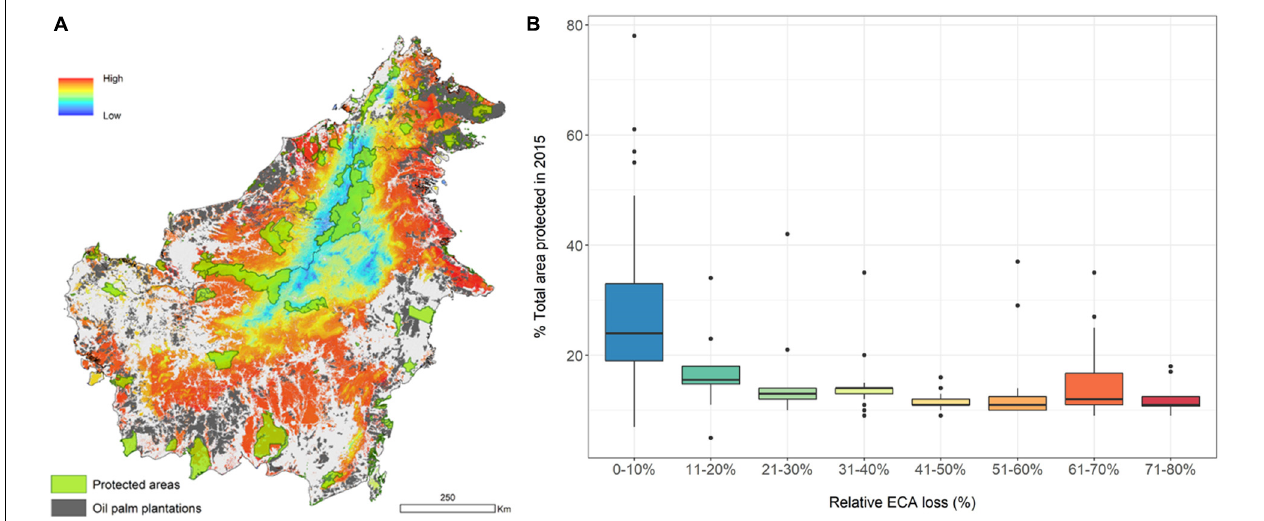
FIGURE 5 | Concentration of vulnerable forest vertebrates constructed by assigning a value from 0 to 5 to each species range according to the percent Equivalent Connected Area (ECA) loss between 1973 and 2015 ( n = 245). Loss from 0 to 0.2 = 1, loss from 0.8 to 1 = 5. Map shows spatial distribution of ECA loss-weighted species (A) , and boxplot shows relationship between ECA loss and percent species’ range within totally protected areas in 2015 (B)